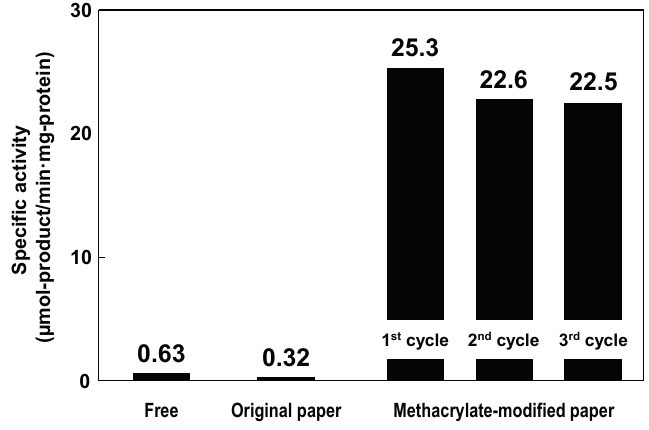
Figure 6. Specific activities of free lipase and lipase immobilized on original and methacrylate-modified papers. Reaction temperature: 23 °C. Stirring rate: 150 rpm.